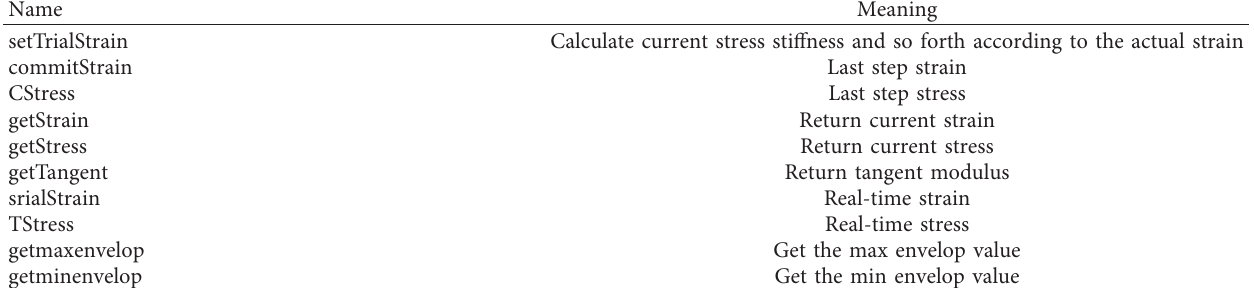
Table 10: Main member variables of the SCVF material.